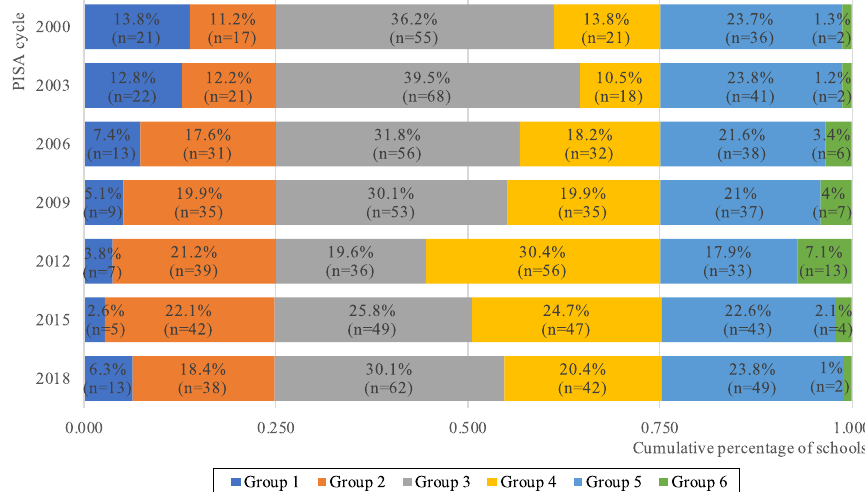
Fig. 2 School groups across PISA cycles. Group 1: resilient; Group 2: non-resilient; Group 3: high-achieving, medium ESCS; Group 4: low-achieving, medium ESCS; Group 5: high-achieving, high ESCS; Group 6: low-achieving, high